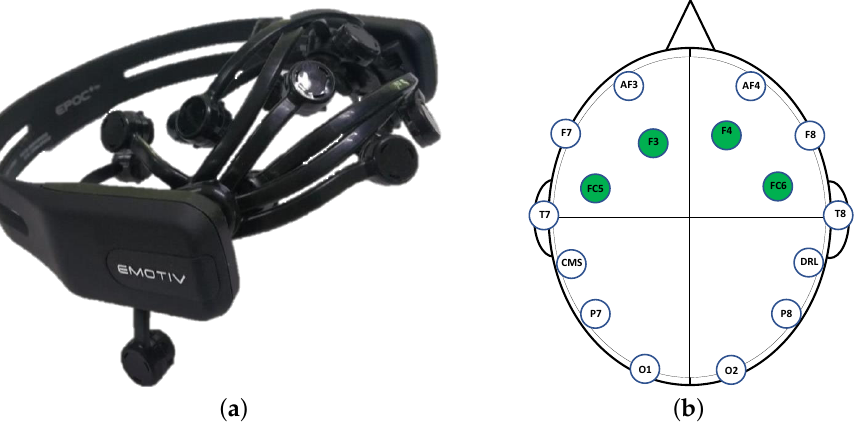
Figure 7. Electrodes’ arrangement and nomenclature. The letter expresses the part of the brain where the sensor is placed, frontal (F), central (C), parietal (P), occipital (O), temporal (T), and frontoparietal (FP). Even numbers are used for the right hemisphere, while odd numbers for the left hemisphere. ( a ) Emotiv EPOC+ headset. ( b ) Electrode headset